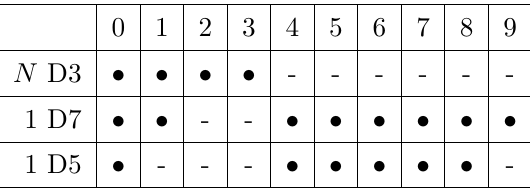
Table 1 . Brane con(cid:12)guration for the holographic Kondo model of